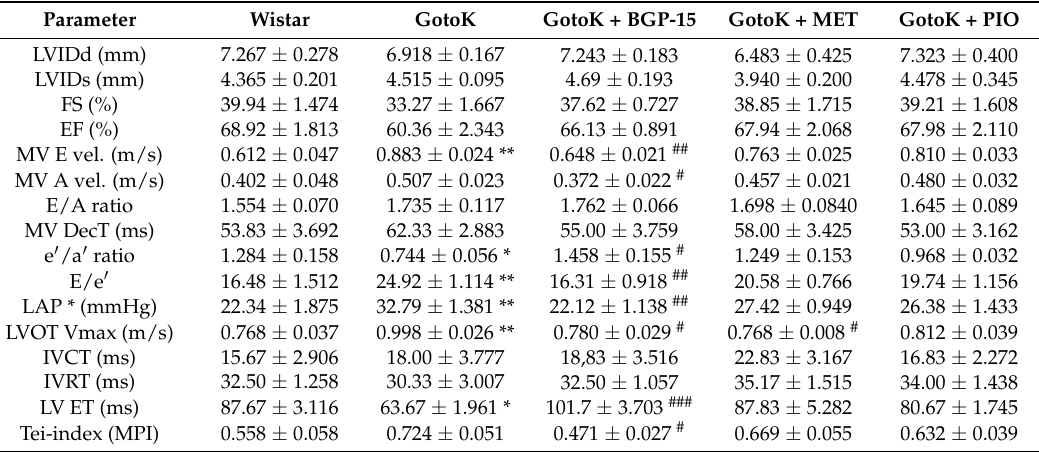
Table 2. Echocardiographic parameters of rats, obtained by 2D, M-mode, Doppler (PW) and tissue Doppler (TDI) imaging at the endpoint of the study. Parameter Wistar GotoK GotoK + BGP-15 GotoK + MET GotoK +